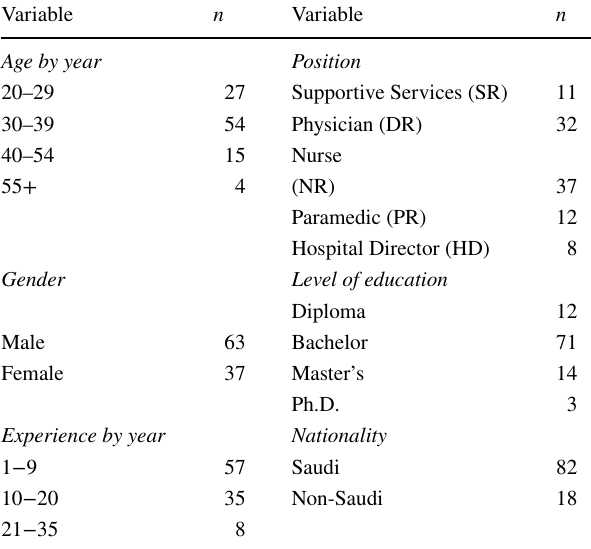
Table 1 Demographic data of the observational approach ( n =